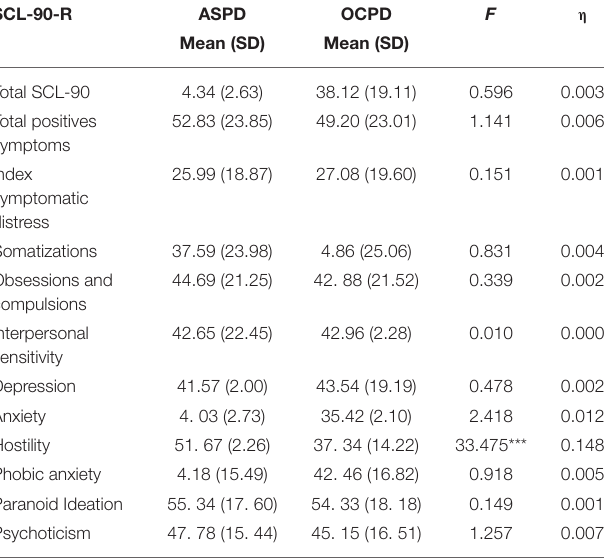
TABLE 2 | Mean, Standard